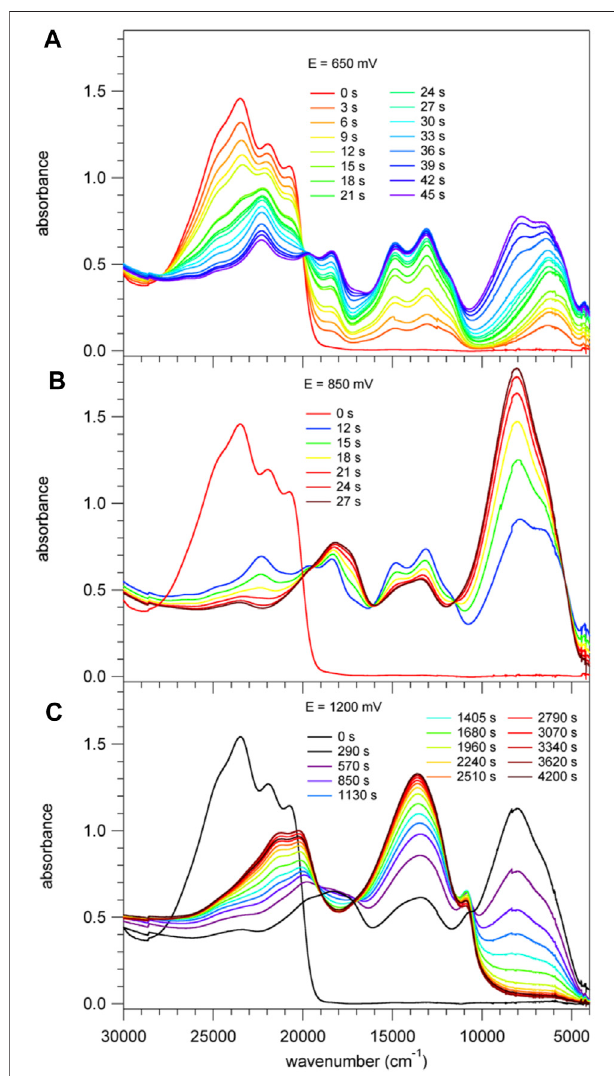
FIGURE5| Absorptionspectraof 1 , c = 2 × 10 − 4 MinCH 2 Cl 2 containing 0.1 M of TBAPF 6 . These spectra were recorded right after applying for a speci fi c time a positive potential of (A) 650 mV, (B) 850 mV and (C) 1200 mV against an Ag wire pseudo reference